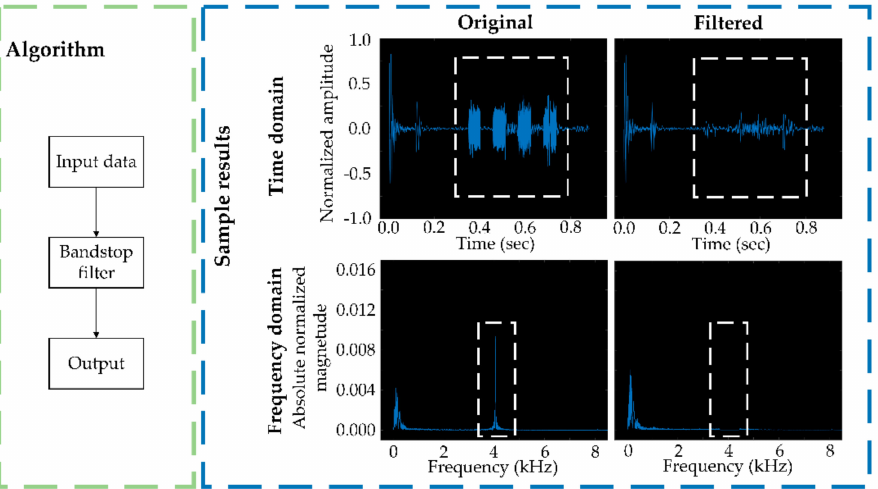
Figure 4. Illustration of the algorithm and sample results for noise removal. White dotted rectangles indicate period and frequency for device-related beeping before and after filtering.